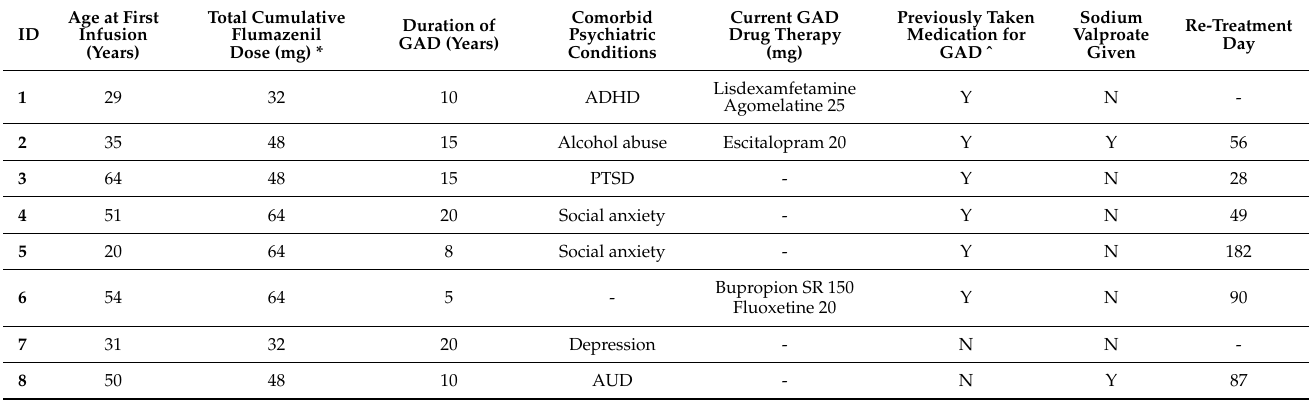
Table 1. Summary of baseline participant characteristics. * Total dose delivered over the entire obser- vation period. ˆ Does not include current GAD drug therapy. ADHD, attention deficit hyperactivity disorder; AUD, alcohol use disorder; GAD, generalised anxiety disorder; SR, slow